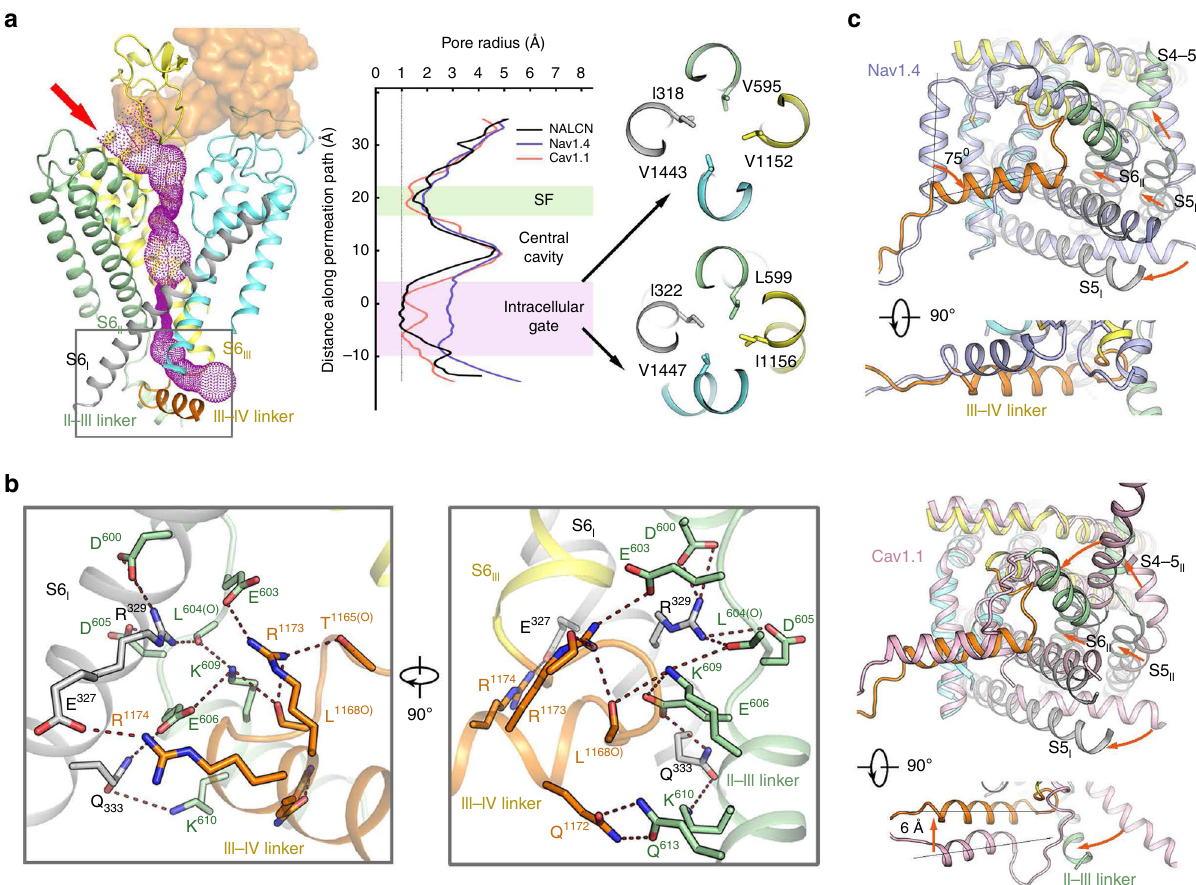
Fig. 6 A closed intracellular pore. a Ion permeation path of NALCN. The pore region of NALCN is shown in cartoon and FAM155A is shown in the surface. The ion permeation path calculated by HOLE 46 is illustrated by purple dots on the left. The extracellular ion entrance is indicated by a red arrow. The details in the rectangular region are shown in b . The corresponding pore radii along the permeation path of human NALCN (black), Na v 1.4 (slate), and Ca v 1.1(pink) are compared in the middle. Two narrowest layers of the intracellular gate are presented in extracellular views on the right. b Zoomed views of the intracellular gate. The electrostatic interactions are indicated by red dashed lines. The residues from S6 I , II-III linker, and III-IV linker are colored black, green, and orange, respectively. c Pore structure comparisons between NALCN and Na v 1.4 (top) or Ca v 1.1 (bottom). NALCN is domain colored, and Na v 1.4 and Ca v 1.1 are colored in slate and light pink, respectively. An intracellular view and a side view are shown for each comparison. The major conformational changes from Na v 1.4 or Ca v 1.1 to NALCN are indicated by red